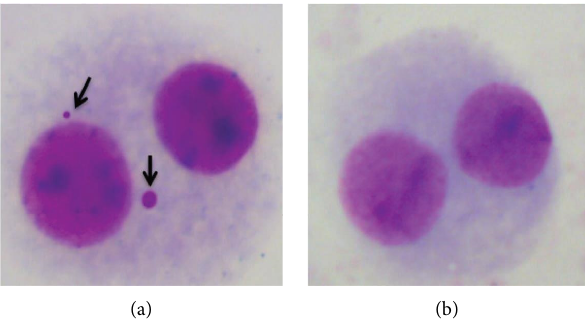
Figure 5: Sample binucleated cells: (a) control (+) as MMC; (b) GPE3 (100 μ M) treated cultures (arrows show MN formations).